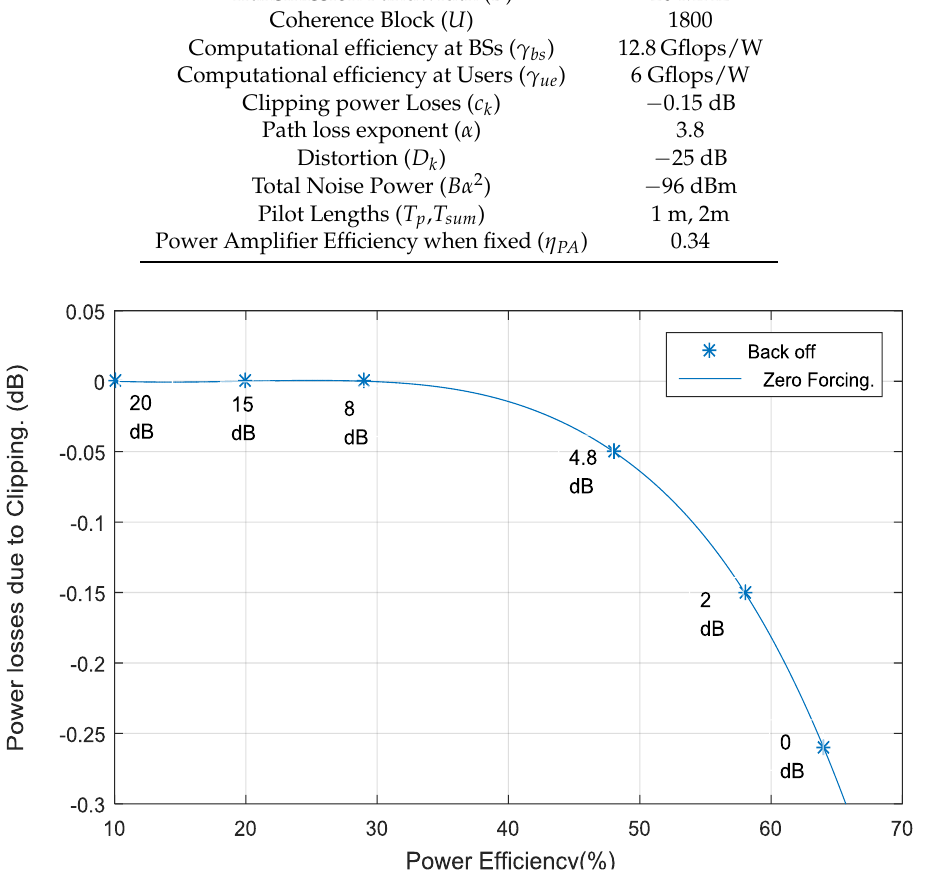
Figure 4. Clipping power losses at different back-offs and power efficiencies.